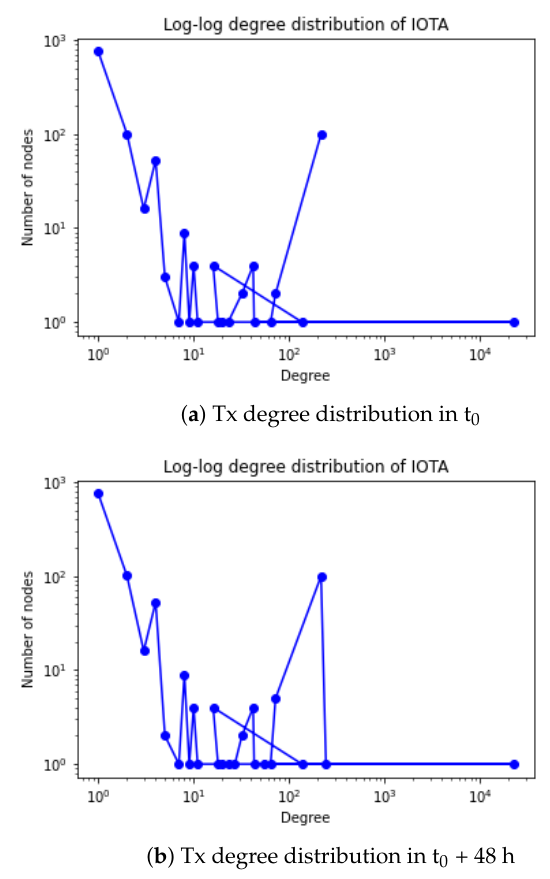
Figure 4. Degree distribution of 1068 IOTA